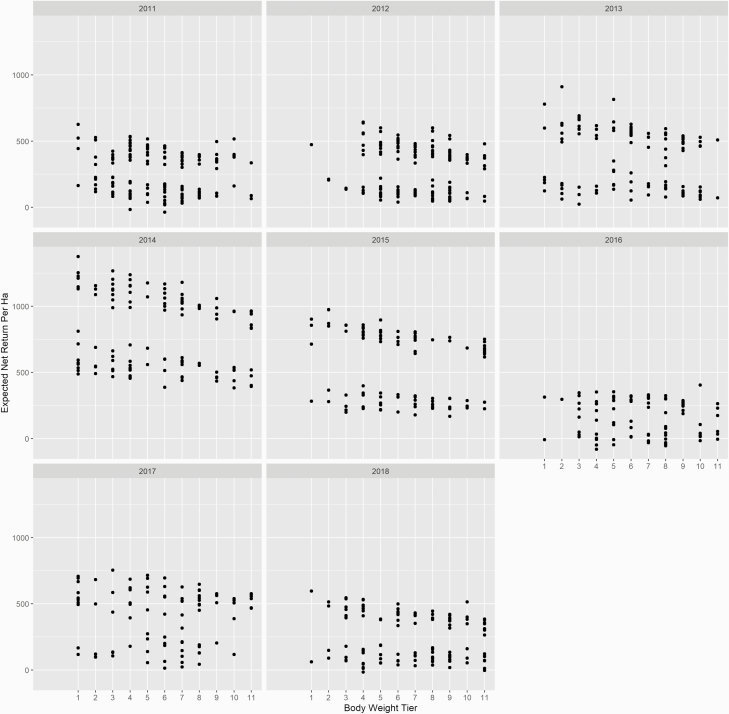
Expected net return/ha plotted against 11 cow body weight tiers (22.67 kg intervals) beginning at 430.83 kg.